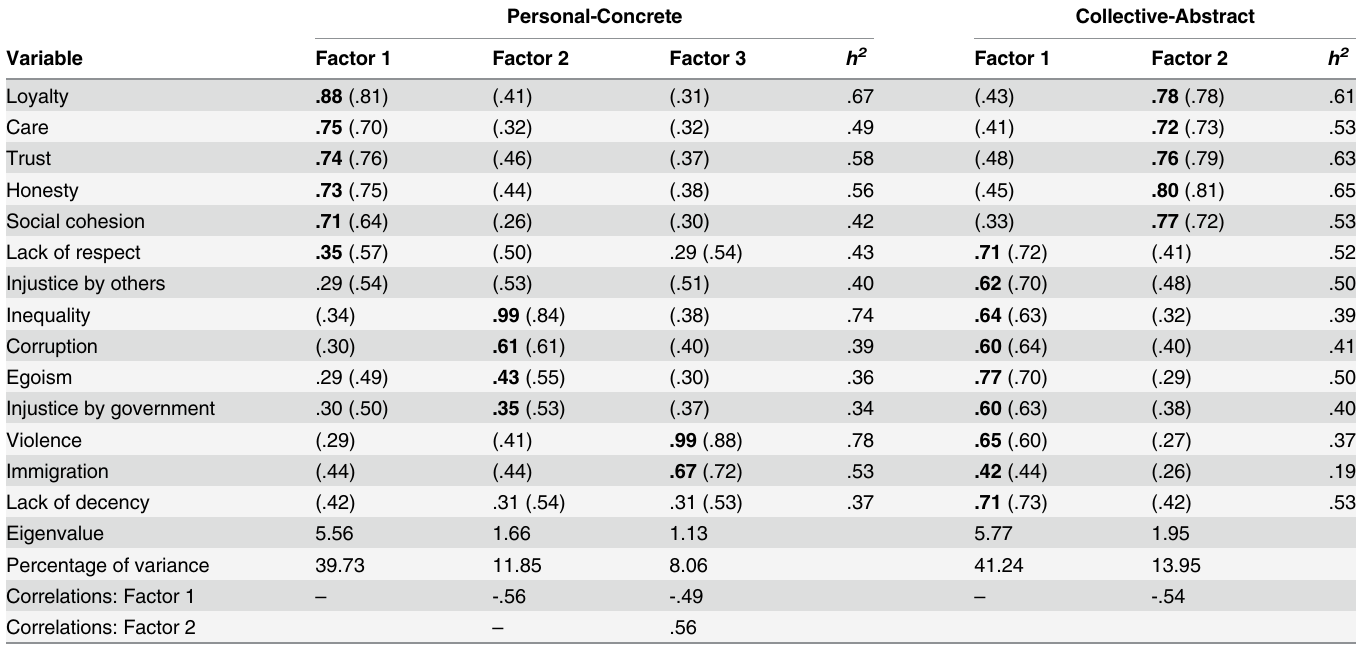
Table 2. EFA Pattern and Structure Coefficients of Personal-Concrete and Collective-Abstract Judgments (Promax; Study